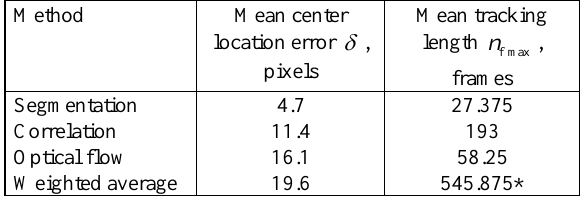
Table 1 . The experimental studies result of the four